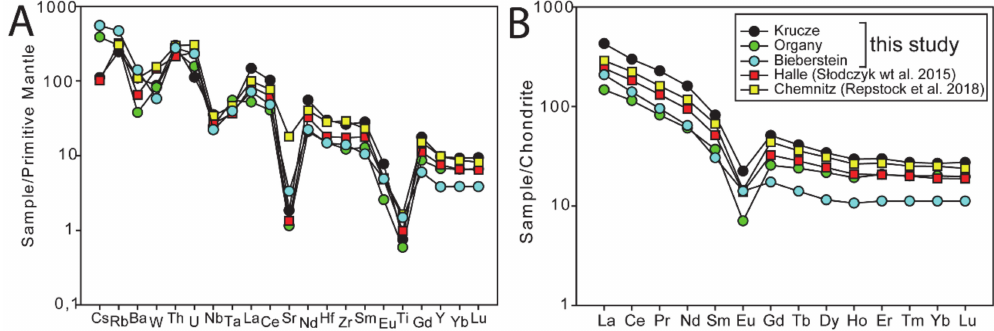
Figure 2. Whole rock composition in spider ( A ) and REE diagrams ( B ). The patterns show the averages of all analyses presented in the Supplementary Materials, with data for Chemnitz and Halle taken from Słodczyk et al. [15] and Repstock et al. [9] respectively. Reference values used to normalize the data are from Sun and McDonough [29].